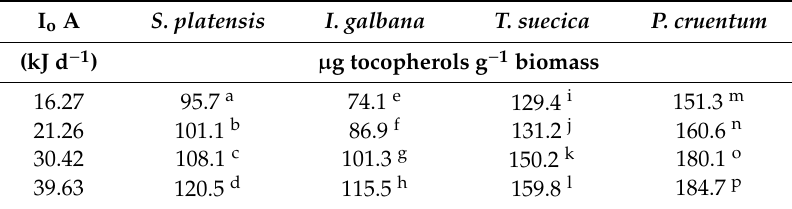
Table 7. Tocopherols concentration. Tocopherols content of the four microalgae in continuous culture at different light intensities.